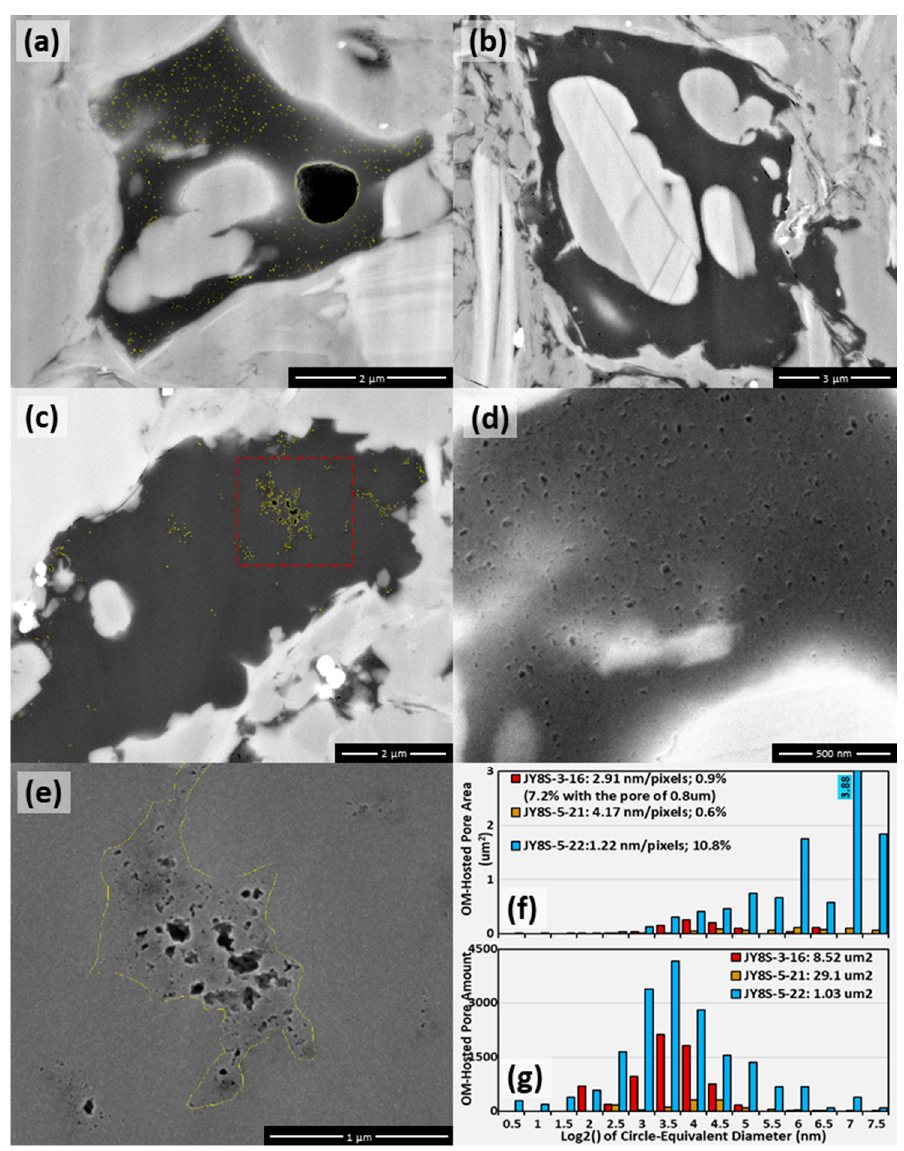
Figure 18. Examples of the nonporous kerogen without bio-mineral boundaries (OM VIII) from Longmaxi-Wufeng Shale, Sichuan Basin. ( a ) SEM image JY8S-3-16 (well ID-sample no.-image no.); ( b ) SEM image JY8S-5-35; ( c ) SEM image JY8S-10-21; ( d ) SEM image JY8S-3-17, a near view of OM in SEM image JY8S-5-35; ( e ) SEM image JY8S-10-22, a near view of OM on SEM image JY8S-10-21; ( f ) pore size distribution of OM-hosted pores determined by OM-hosted pore area; ( g ) pore size distribution of OM-hosted pores determined by pore amount. The red rectangle indicates the location of the near view of SEM images; the yellow curve indicates the boundary of OM-hosted pores.